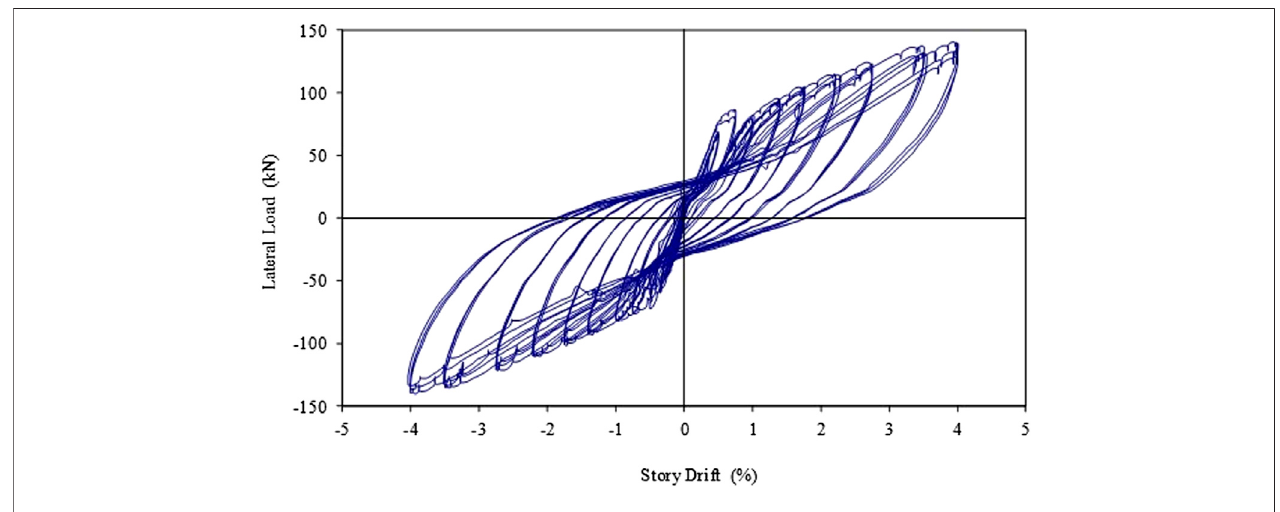
FIGURE 10 | Load — story drift response of specimen HBD_16_20_C.